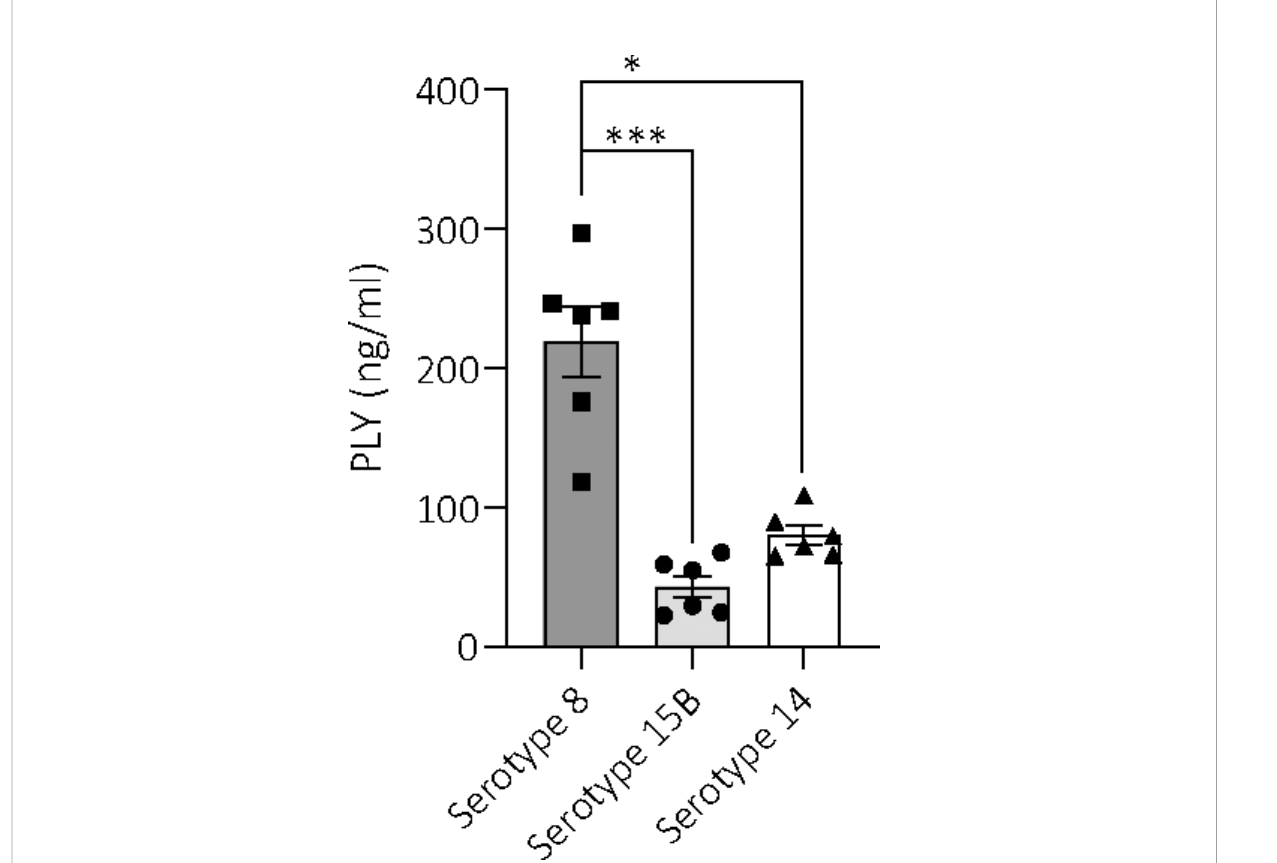
FIGURE 7 Amount of pneumolysin in total lysates of serotypes 8, 15B and 14. ELISA-based quanti fi cation of the amount of pneumolysin released by the three different serotypes (at a bacterial concentration of 5 x 10 6 CFU/ml) upon lysis by penicillin treatment reveals signi fi cantly higher levels of the toxin in serotype 8, compared to serotype 15B and 14. Data are represented as mean values. Samples were quanti fi ed in triplicates from two independent preparations, *p < 0.0004, ***p <